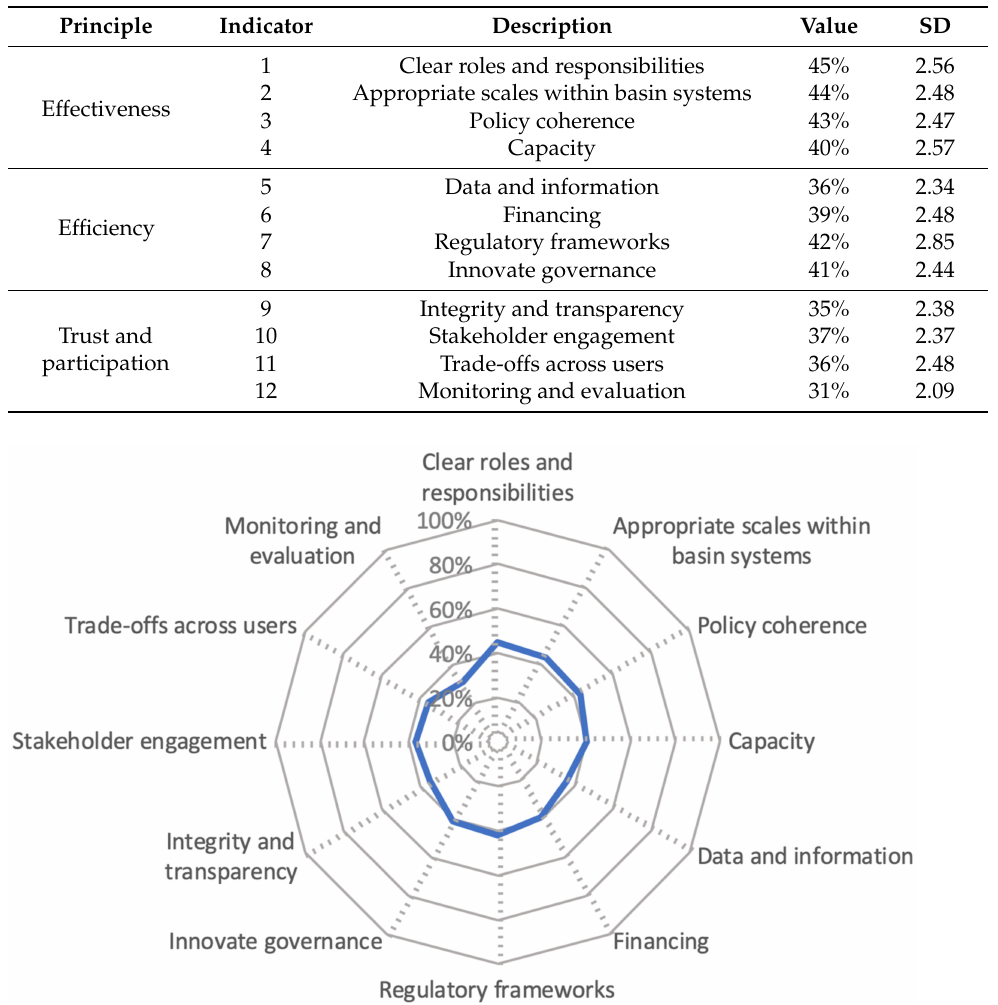
Figure 4. Indicator